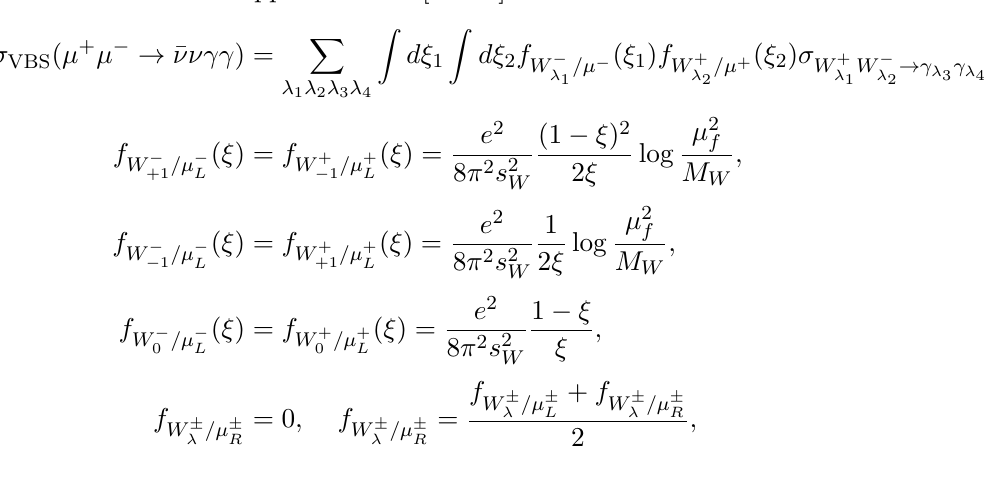
Figure 1 . The typical Feynman diagrams of the aQGCs contribution to the process µ + µ − → γγν ¯ ν . effective vector boson approximation